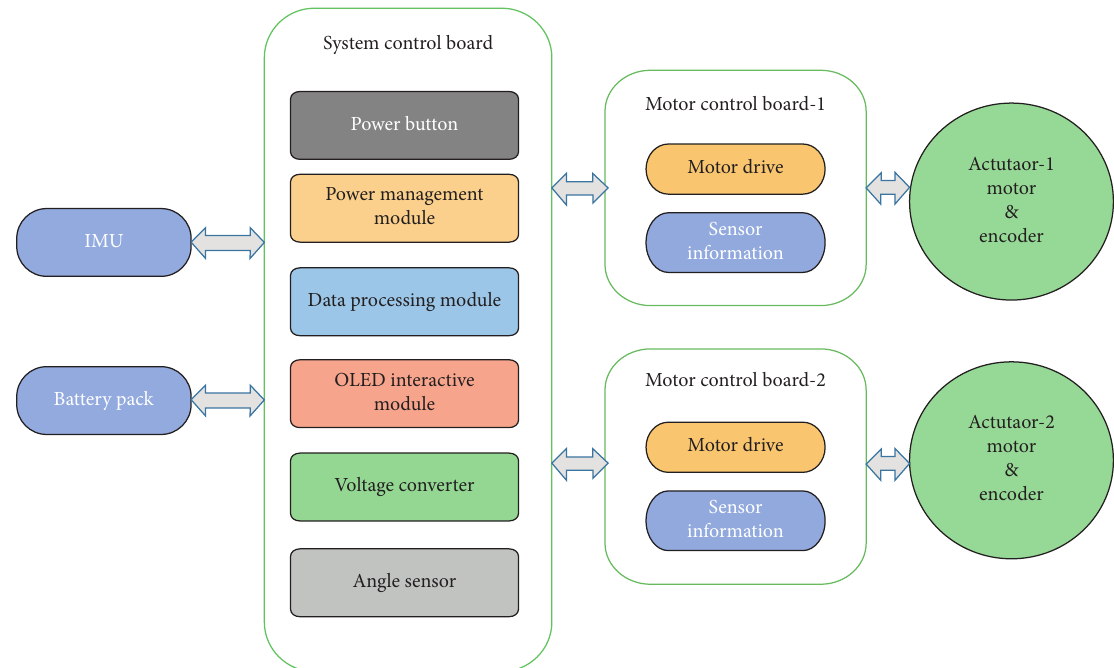
Figure 6: The embedded electronics system of SIAT-WEXv2. IMU, system control board, and motor control boards are installed in the lumbar support backrest; IMU and encoders are used to record the angle information of lumbar and legs, respectively; battery pack, voltage converter, and power management module can provide stable energy for the